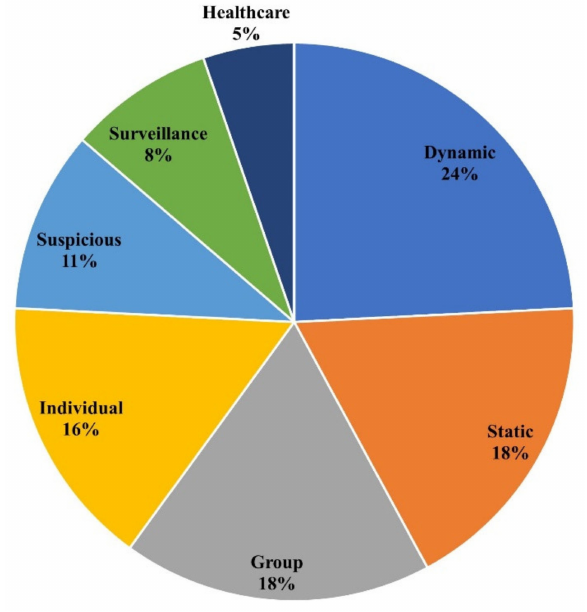
Figure 3. Frequency of application areas targeted by existing literature on